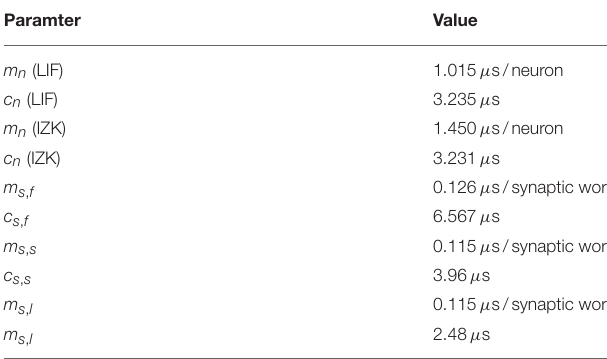
spikes in blue, inhibitory in red). Network oscillations of ≈ 15